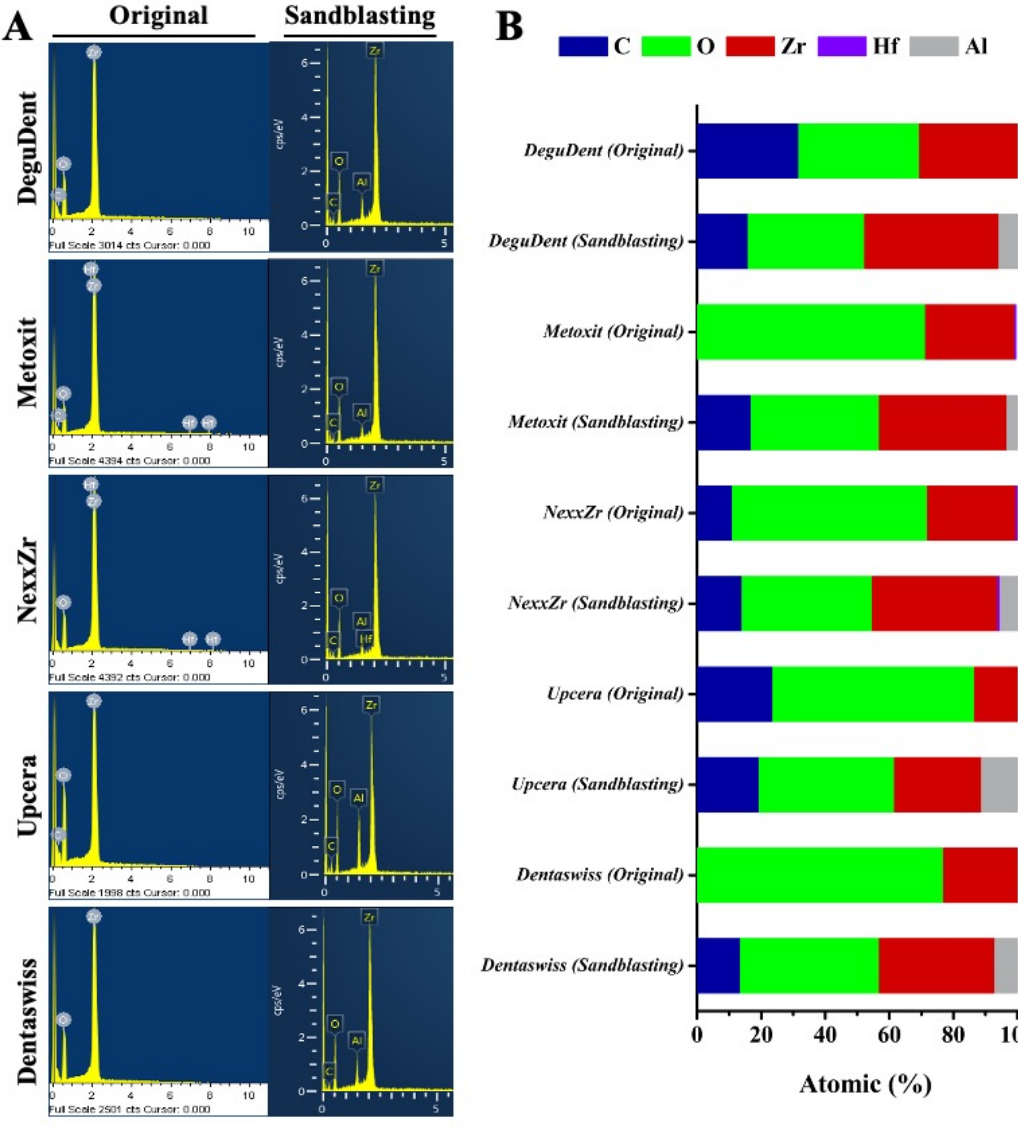
Figure 6. Surface element analysis of zirconia samples of different brands by EDS. ( A ) Qualitatively; ( B ) Quantitatively.